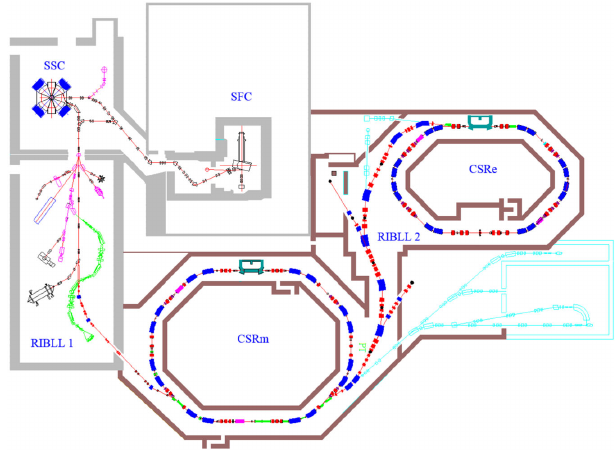
FIG. 1. Layout of the HIRFL-CSR accelerator